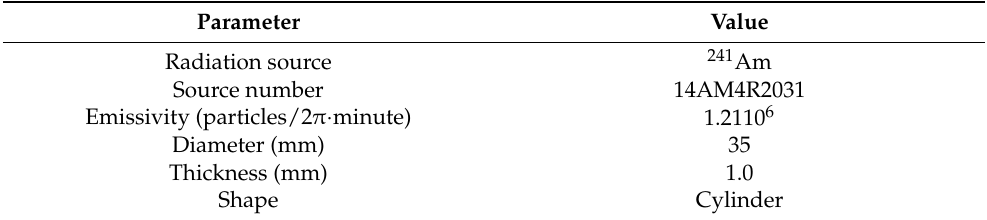
Table 2. Radiation source parameters used in the